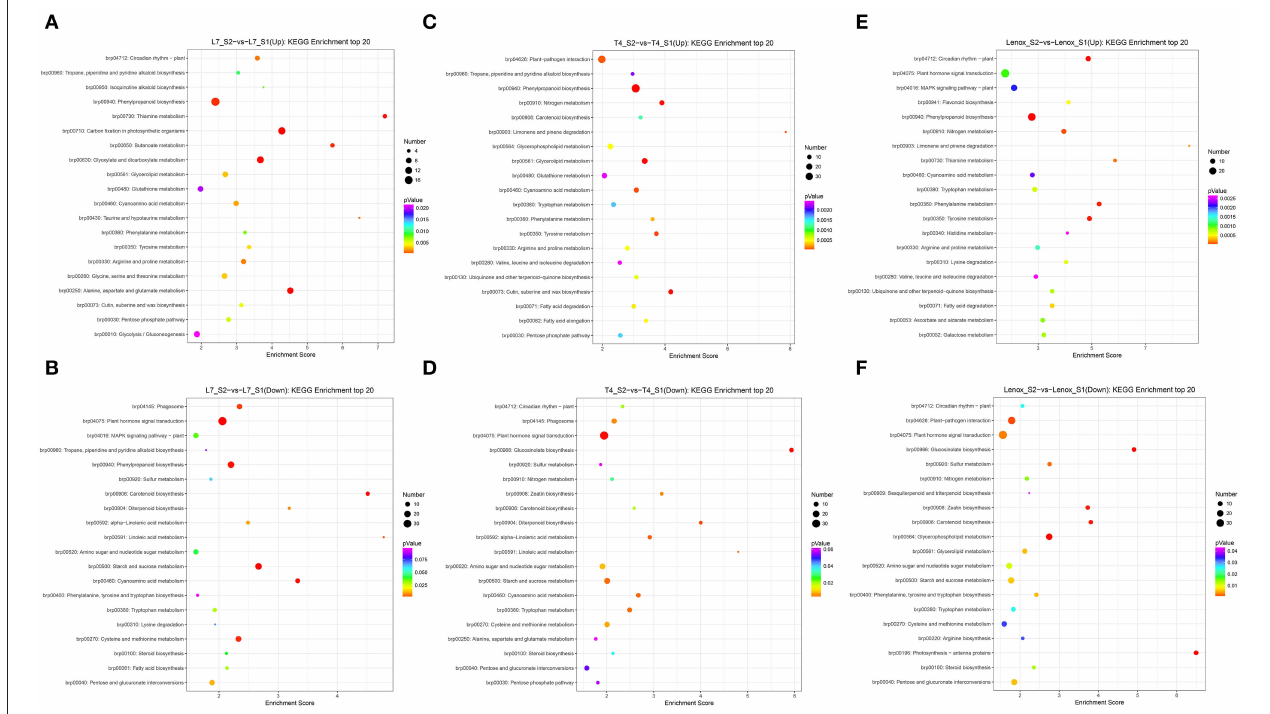
FIGURE 4 | KEGG enrichment of differently expressed genes in the S2 stages of (A,B) Longyou-7 (L7), (C,D) Tianyou-4 (T4), and (E,F) Lenox.